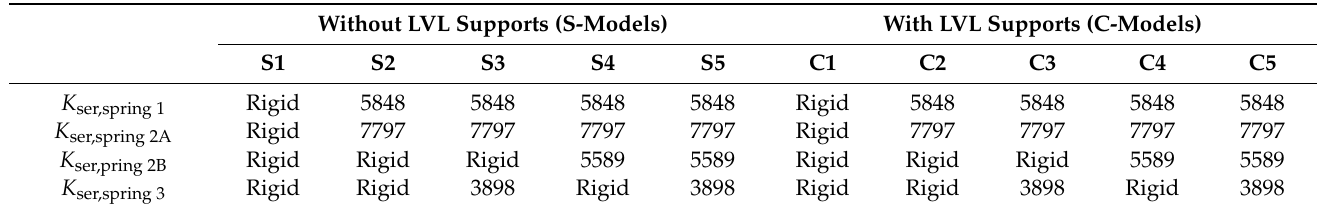
Table 5. Numerical models analysed and stiffness values considered for each of the springs (N/mm). Without LVL Supports (S-Models)